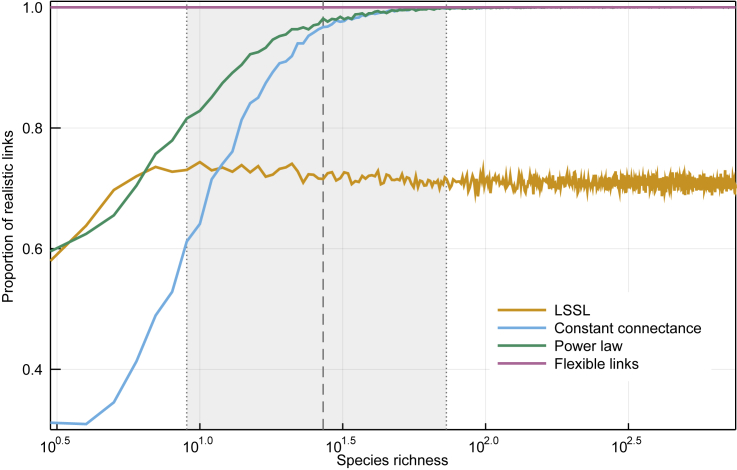
Only the Flexible Links Model Makes Realistic Predictions for Small CommunitiesHere we show the proportion of posterior predictions from each of our four models that fall outside ecologically realistic values. The proportion of predictions in the correct range increases with species richness for the constant connectance and power law models. Shaded area shows the 5%, 50%, and 95% quantiles of the distribution of S, demonstrating that many communities have potentially incorrect predictions under previous models.